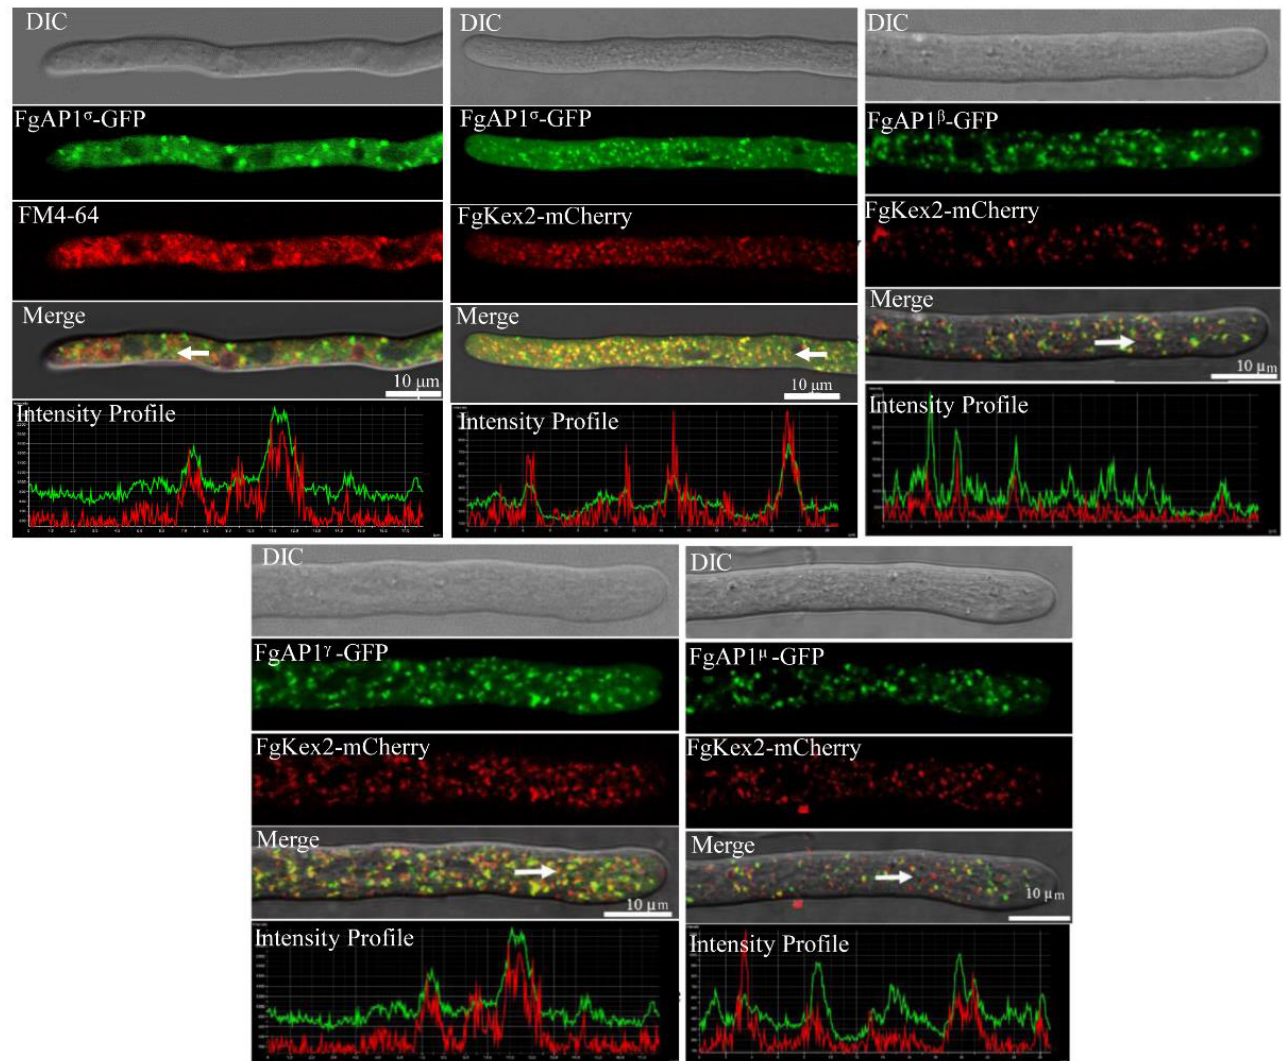
Figure 6. The localization of AP1 complex in F. graminearum . Colocalization of FgAP1 σ -GFP with FM4-64 and trans-Golgi network (TGN, FgKex2-mCherry) as well as that of FgAP1 β -GFP, FgAP1 γ - GFP, and FgAP1 µ -GFP with FgKex2-mCherry in F. graminearum . Images were captured from laser scanning confocal microscope. Bar = 10 μm.